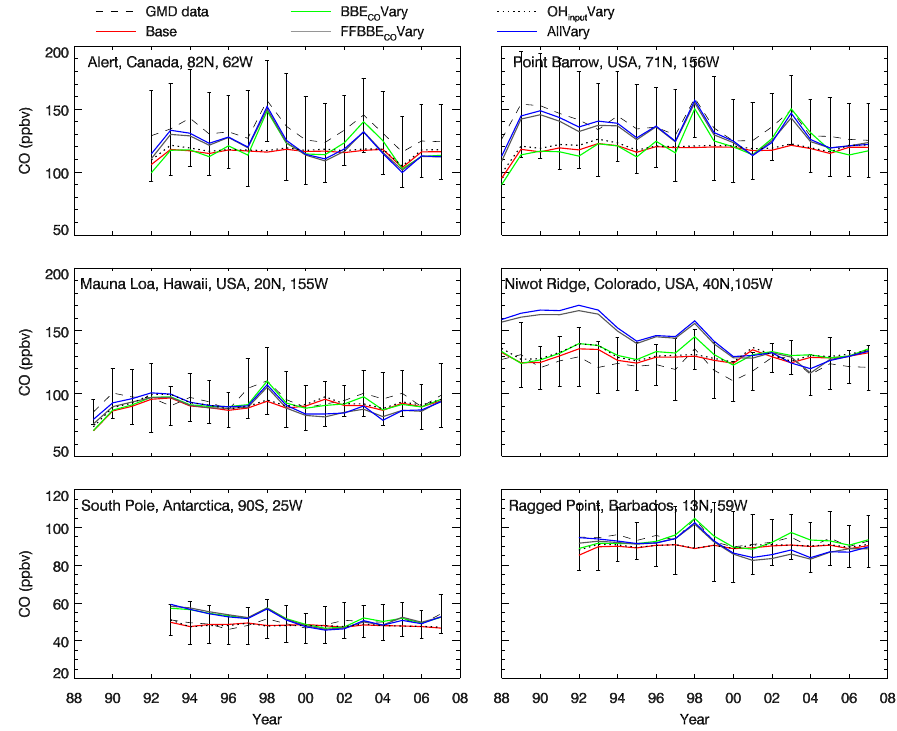
Figure 10. Annual mean CO (ppbv) from several scenarios and observations at six GMD stations. Vertical lines represent the standard deviation of the observed annual